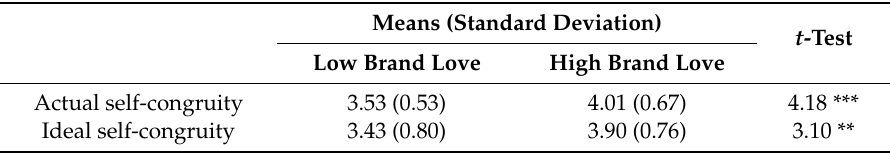
Table 5. Di ff erences in self-congruity measures between low and high brand love